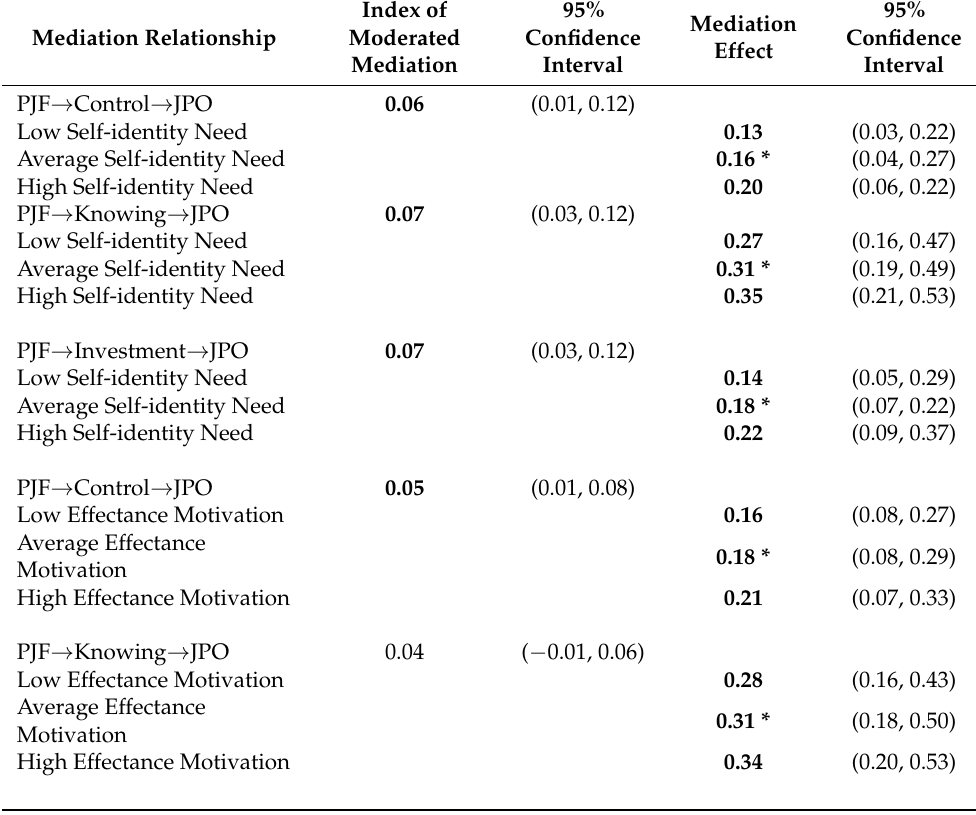
Table 3. Results from tests of moderated mediation